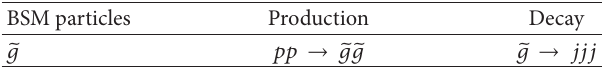
Figure 2: Projected exclusion reach for the LHC Run 2 and beyond [6] for the RPV squark simplified model. In this picture the many colored lines represent the expected exclusion under a given assumption of Jet Energy Scale (JES) uncertainty and background systematics. For more details on this assumption, we refer to the original work [6].